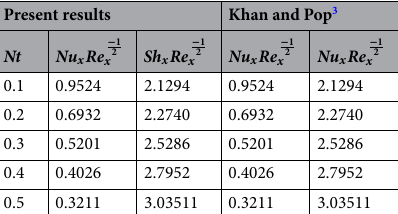
1 1 2 x and Sh x Re − 2 x against Nt for